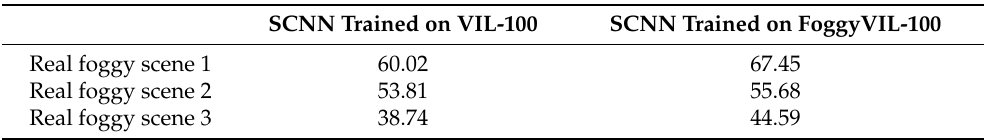
Table 11. Lane detection results (F1-measure averaged from 100 images) of SCNN on real foggy scenes from VIL-100 dataset, with the models trained on VIL-100 and FoggyVIL-100, respectively.